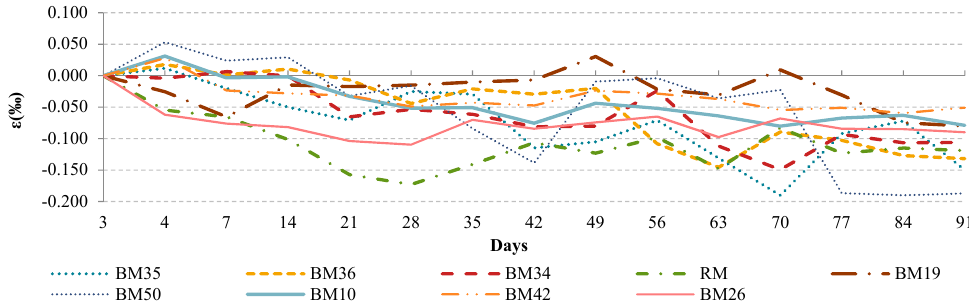
Figure 4. Comparison of drying shrinkage of concrete mixtures.